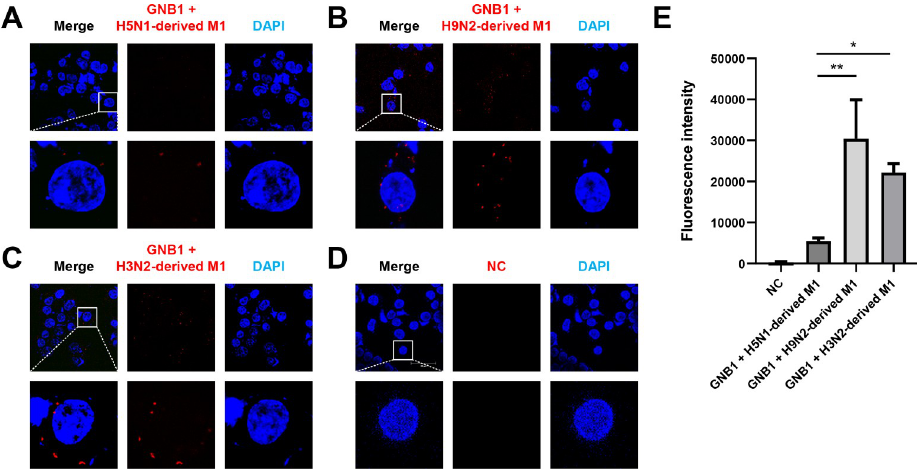
transfected with (A) H5N1-derived M1 plasmid, (B) H9N2-derived M1 plasmid, (C) H3N2-derived M1 plasmid, or (D) empty vector as negative control. The PLA was performed using antibodies specific to influenza M1 and endogenous GNB1 proteins. The fluorescence of cells was analyzed by a fluorescence confocal microscope (red fluorescent signal). Nuclei were stained with DAPI (blue). (E) Multiple images (A–D) were processed by BlobFinder to measure the PLA fluorescence intensity per cell (~30 cells total for each condition). Graphs show means ± SD of three independent experiments ( � , P < 0.05; �� , P <